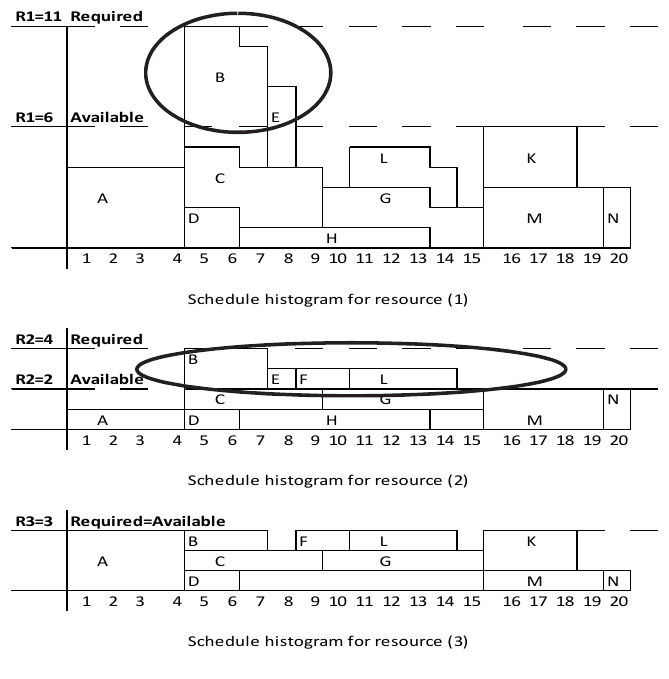
Fig. 14. Project schedule before resources